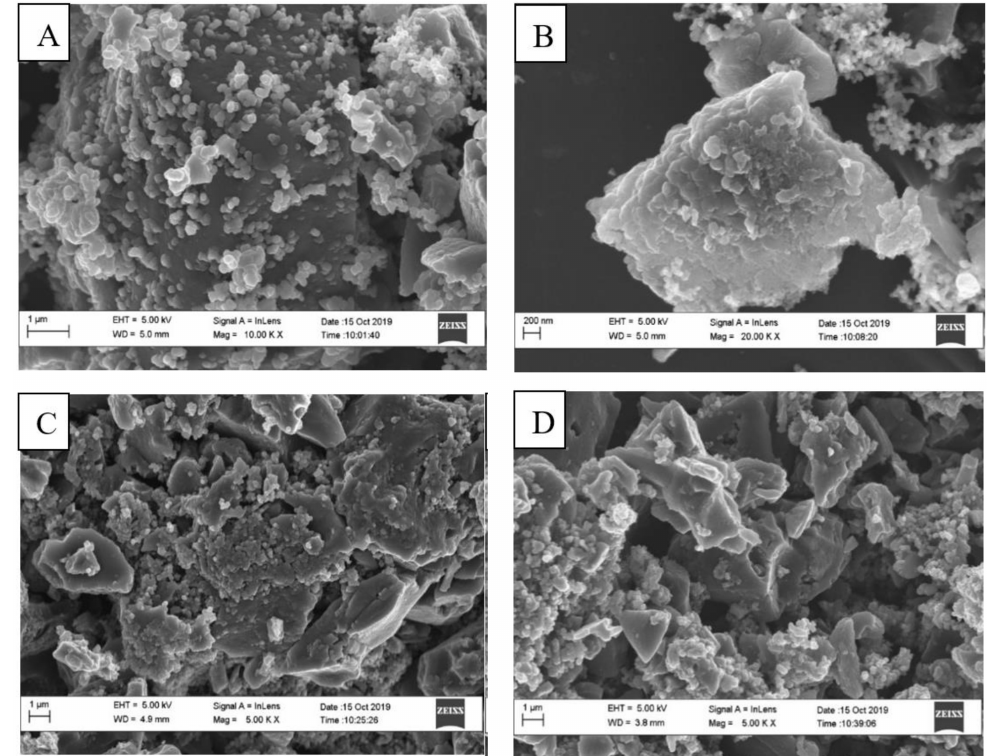
Figure 3. ( A ) Activated Carbon (AC) + Carbon Black (CB) 60 min dry mix, ( B ) Activated Car- bon (AC) + Carbon Black (CB) + Polyvinylidene Difluoride (PVDF) 30 min wet mix with N , N - dimethylacetamide (DMAC) as solvent and dried at 130 ◦ C for 12 h, ( C ) Electrode E2b not-calendered, thermally treated at 130 ◦ C for 16 h and ( D ) Electrode E4 calendered, thermally treated at 130 ◦ C for 16